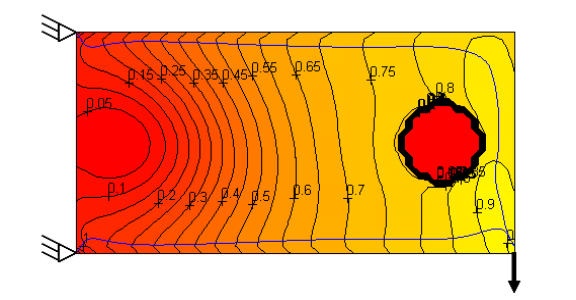
Fig. 23. Transferred and potential transferred force to th